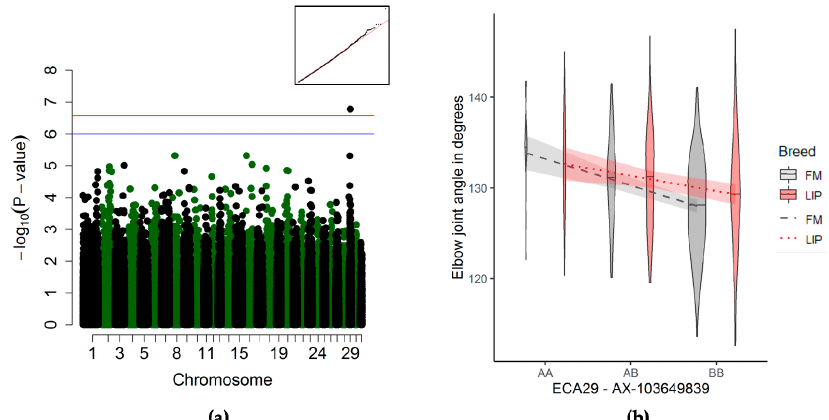
Figure 3. Genome-wide association study (GWAS) for the elbow joint angle ( n = 495). (a) Manhattan plot and Q–Q-plot (inset) with the blue line representing the suggestive significance threshold ( p < 10 − 6 ) and the red line representing the significance threshold (p Ind <2.66 × 10 − 7 ). (b) Violin plot and trend lines (standard error in translucent) representing the genotype effect of the significant SNP on ECA29 on the elbow joint angle. on the elbow joint angle. Genes 2019 , 10 , 370